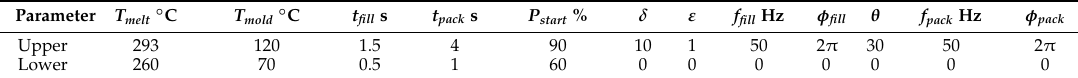
Table 5. The boundary values of the design parameters.